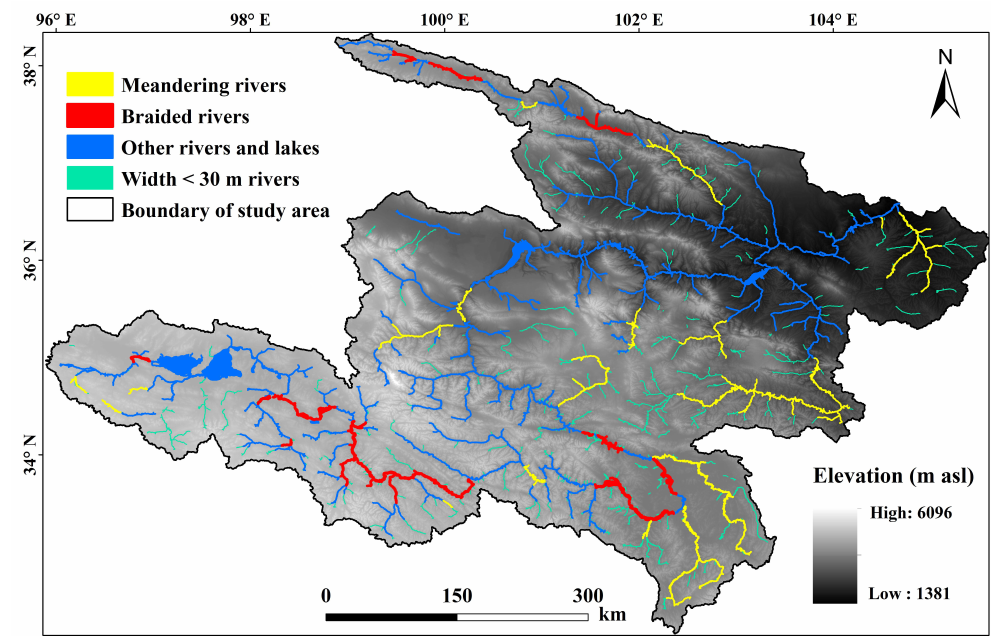
Figure 9. River extraction results from Sentinel-2. Width < 30 m rivers are disconnected rivers extracted from Sentinel-2 in the study area.